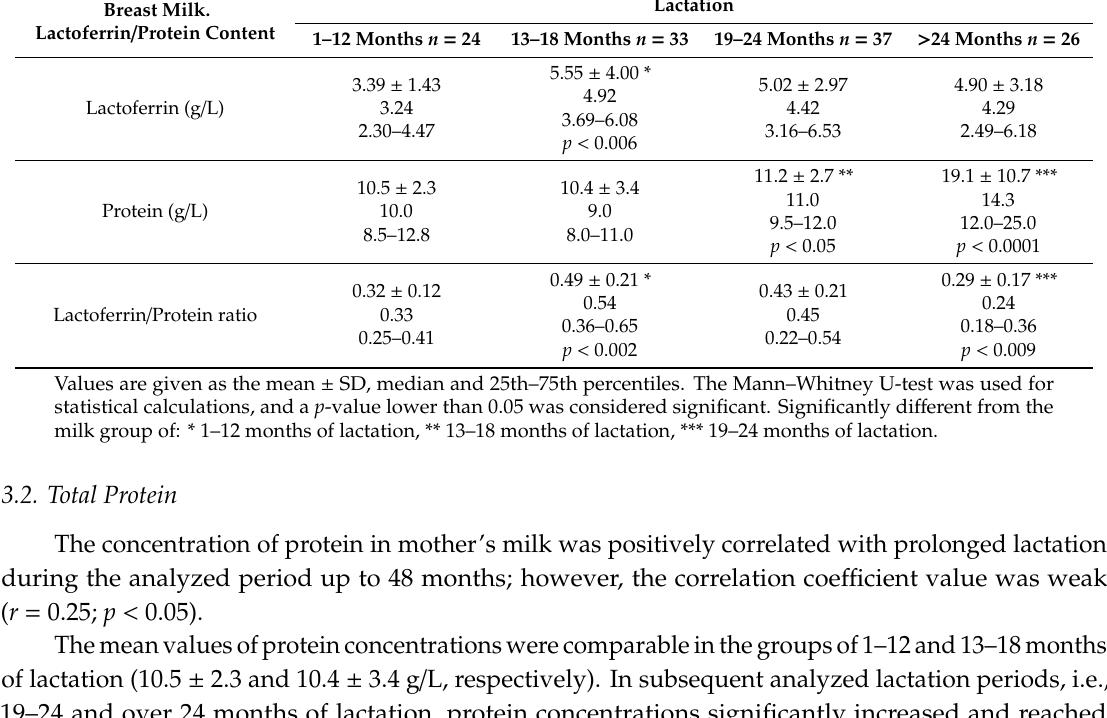
Figure 1C. The calculated coe ffi cient of Lf / Protein in the group of 1-12 months of lactation reached 0.32 ± 0.12, significantly increasing in the 13–18-month group (0.49 ± 0.21, p < 0.002) and remaining at a comparable level in the 19–24-month group (0.43 ± 0.21), decreasing in the > 24 months group to 0.29 ± 0.17 ( p < 0.009; Table 2, Figure